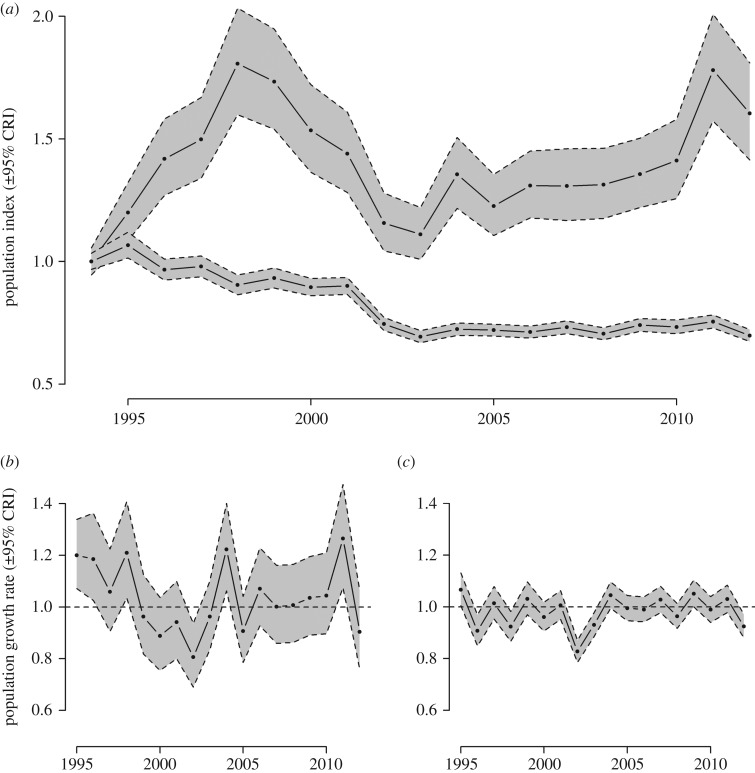
Temporal trends in willow warbler (a) population index in the northwest (top line) and southeast (bottom line) regions (indices in both regions set to 1 in 1994), and annual population growth rates in the (b) northwest and (c) southeast, predicted from IPMs.